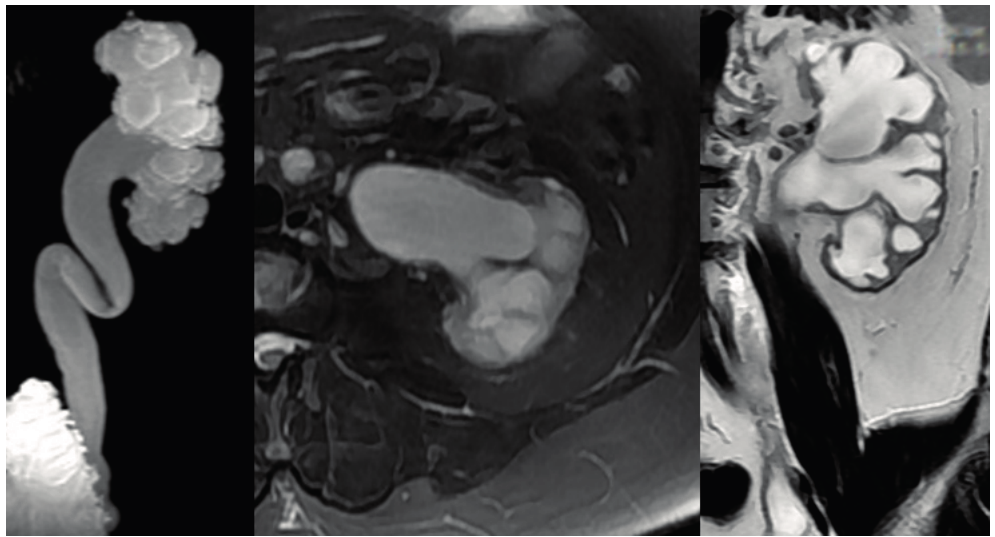
Figure 6. Grade 4 with UUTD-MRU grading